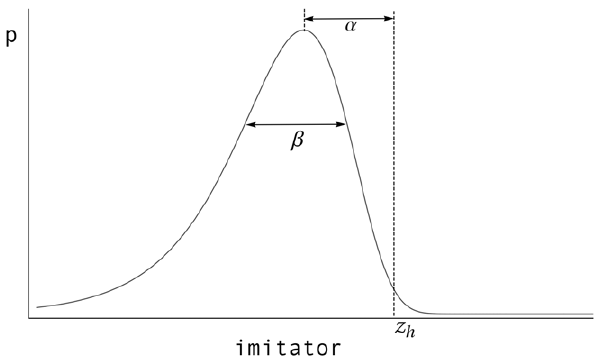
Figure 1. Gumbel probability density function for imperfect